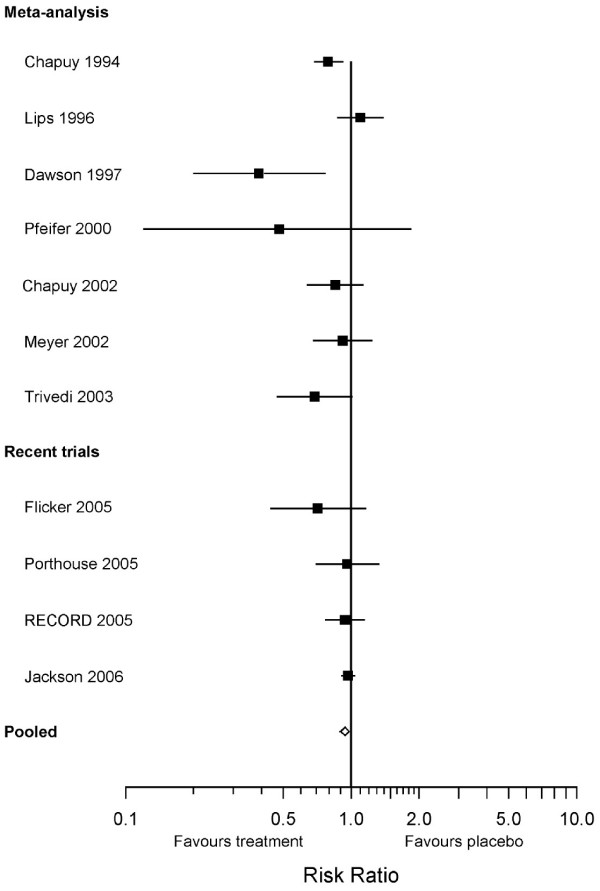
Risk ratio for any nonvertebral fracture in a comparison of vitamin D supplementation (treatment) with placebo. The trials are ordered according to year of publication. Bars represent 95 percent confidence intervals. Pooled risk ratio, 0.94 (95 percent confidence interval, 0.89 to 0.98).